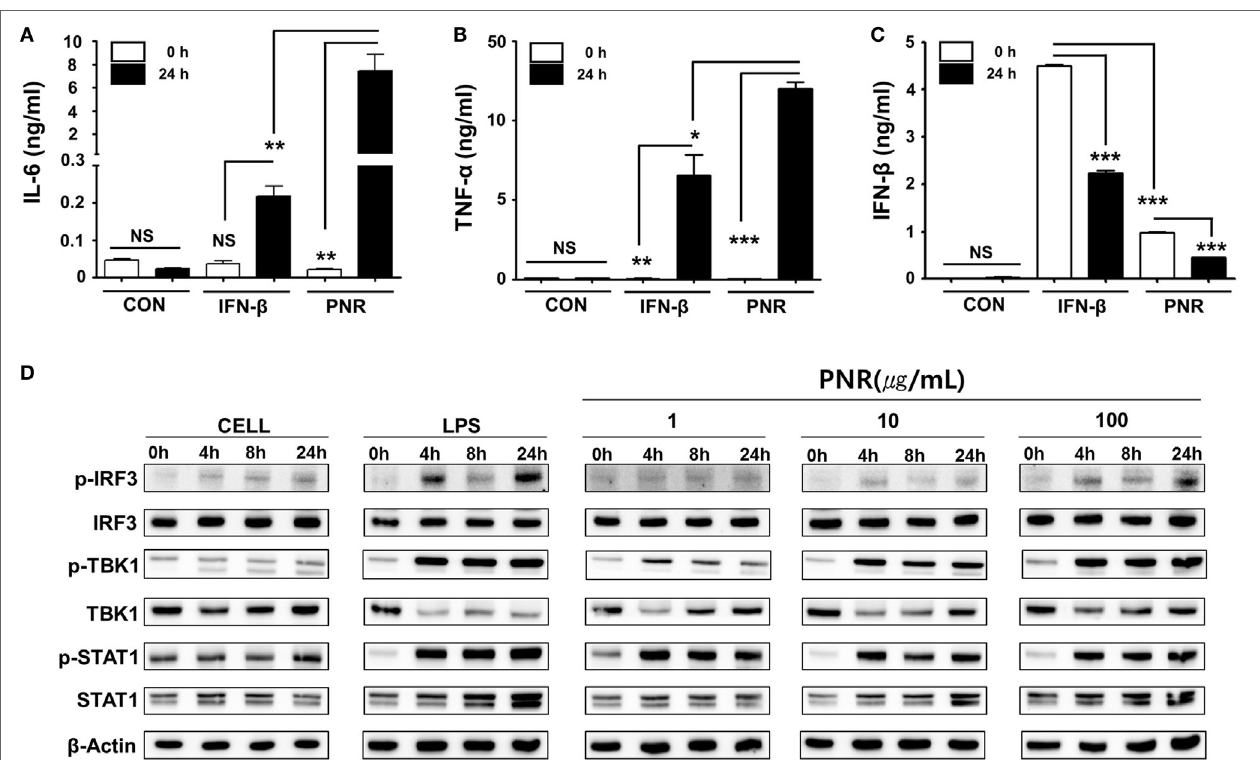
FigUre 3 | Induction of pro-inflammatory cytokines and activation of type-I interferon (IFN) by Panax notoginseng root (PNR) in vitro . (a–c) RAW 264.7 cells were treated with DMEM containing 10% fetal bovine serum (FBS) alone, 1,000 U/mL recombinant mouse IFN- β , or 100 µg/mL PNR and incubated at 37°C and 5% CO 2 . Supernatant from each group was harvested at 0 and 24 h and clarified by centrifugation at 2,500 g for 10 min at 4°C. Clarified supernatants were dispensed into murine interleukin (IL)-6, tumor necrosis factor (TNF)- α , and IFN- β capture antibody-coated enzyme-linked immunosorbent assay plates to measure cytokine secretion. The test was performed in duplicate. (D) Western blotting was performed using the whole-cell lysates of macrophage-type cells treated with or without PNR (1, 10, and 100 µg/mL) to assess the expression of the nonphosphorylated and phosphorylated forms of IRF3, TANK-binding kinase 1 (TBK1), STAT1, and β -actin over time. Similar results were obtained, and the experiment was performed three times independently. Bar graph (mean ± SEM) statistics were determined using two-way ANOVA with Bonferroni’s correction (posttest), *** P < 0.001; ** P < 0.01; * P < 0.05. n.s., not